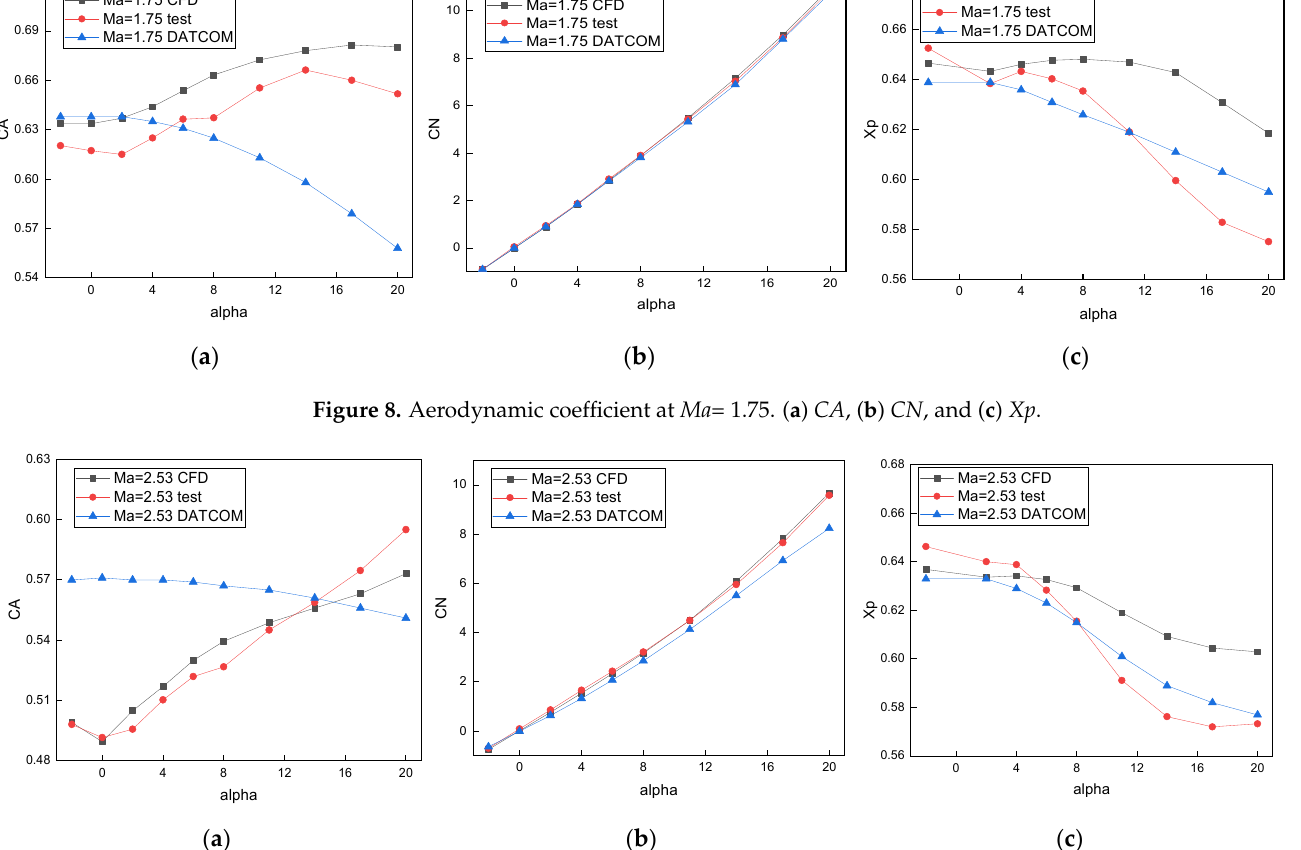
Figure 9. Aerodynamic coefficient at Ma = 2.53. ( a ) CA , ( b ) CN , ( c ) Xp.